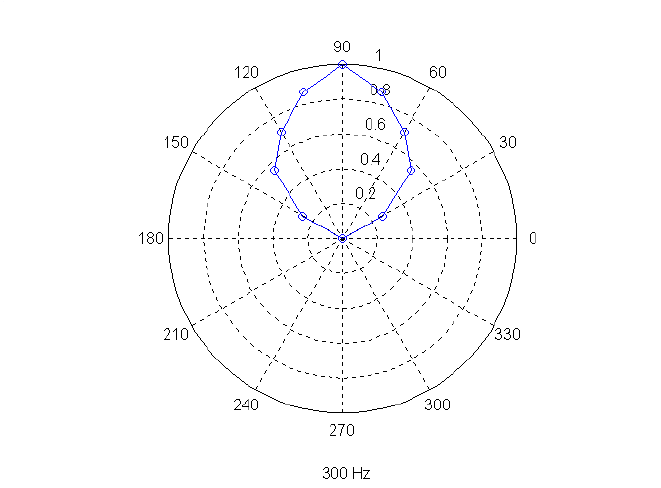
Figure 15. Experimentally obtained polar diagram of a 300 Hz resonant element.